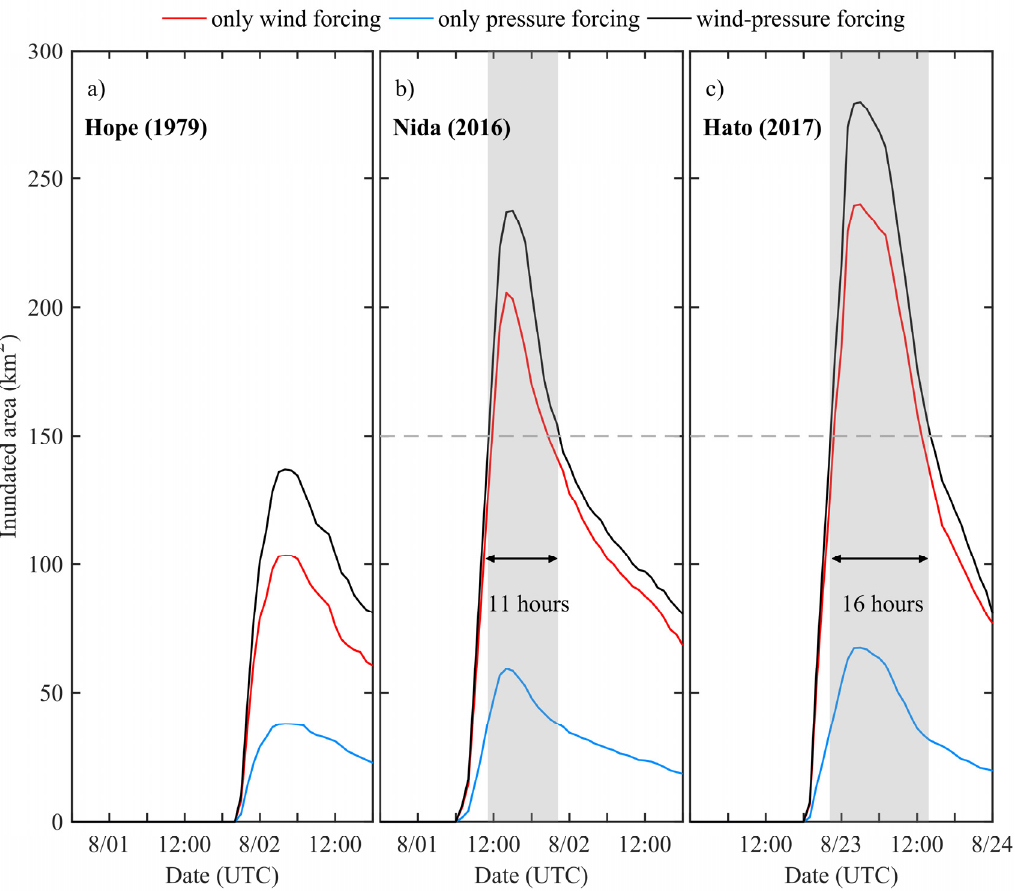
Figure 7. ( a – c ) Time series of three typhoons’ simulated inundation area (units: km 2 ) generated by di ff erent forcing fields. The blue curves present the inundation area of the pressure forcing, the red curves present the inundation area of the wind forcing, and the black curves present the inundation area of the wind-pressure forcing. The grey shaded area in ( b ), and ( c ) are present the maximum duration of the serious inundation for the Typhoon Nida (2016) and Typhoon Hato (2017), respectively.